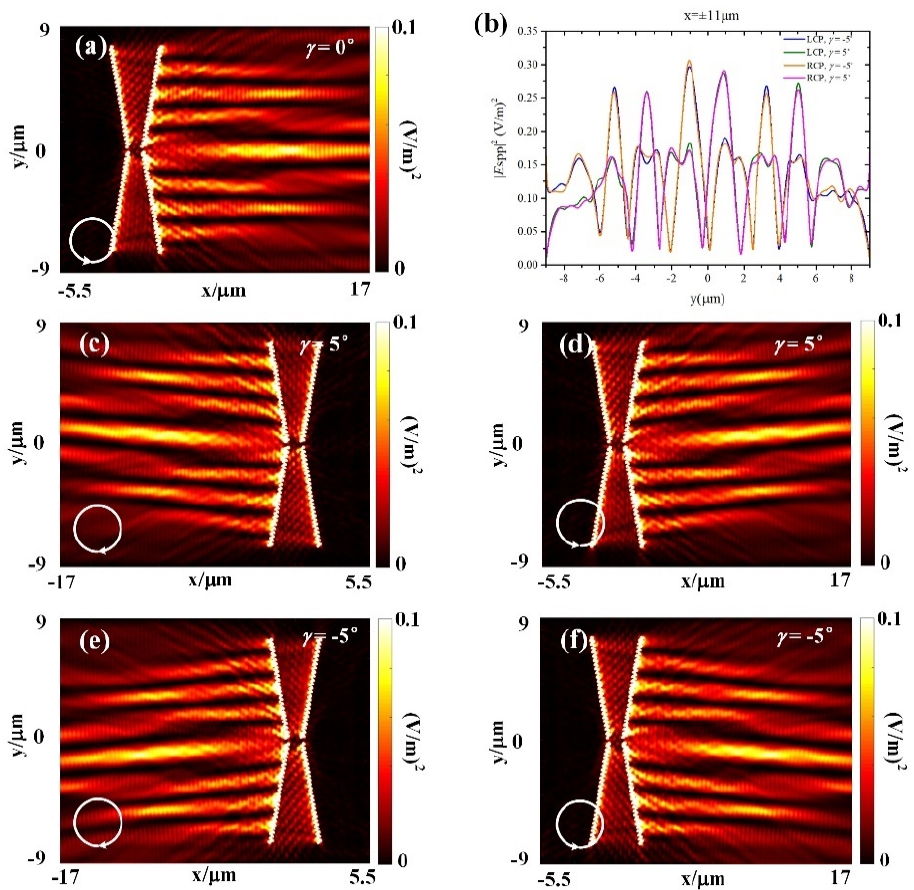
Figure 6. ( a ) Three-channel nondiffracting SPP-beam intensity distribution when the incident is RCP light with inclined angle 0 ◦ . ( b ) The transversal electric field intensity distributions at x = ± 11 µ m. The blue and orange lines correspond to the inclined angle of − 5 ◦ under different polarization states; the green and purple lines correspond to the inclined angle of 5 ◦ under different polarization states. ( c – f ) Three-channel nondiffracting SPP-beam intensity distribution under different incident light polarization states and different inclined angles.